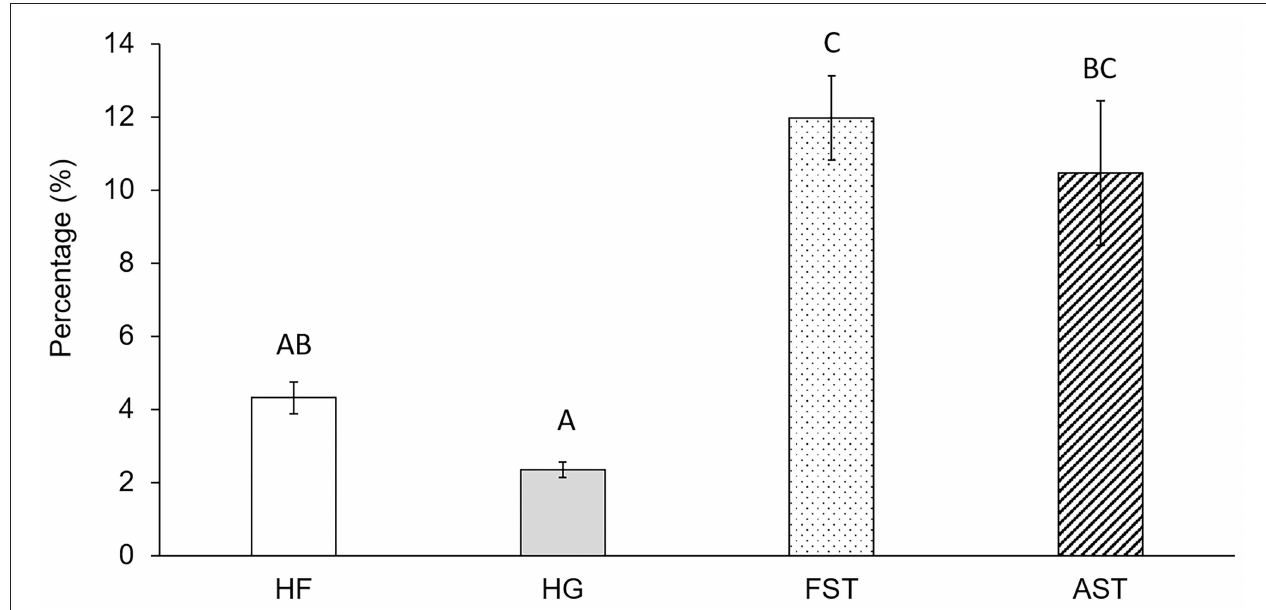
FIGURE 4 | Percentage of termites in pre-molting stage. Different upper case letters represent statistically different group according to Tukey’s HSD ( α = 0.05). HF ( ♀ AST × ♂ FST), HG ( ♀ FST × ♂ AST), FST ( ♀ FST × ♂ FST), and AST ( ♀ AST × ♂ AST). FST, Formosan subterranean termites; Coptotermes formosanus Shiraki; AST, Asian subterranean termites; C. gestroi (Wasmann). For each mating types, 3 different colonies were